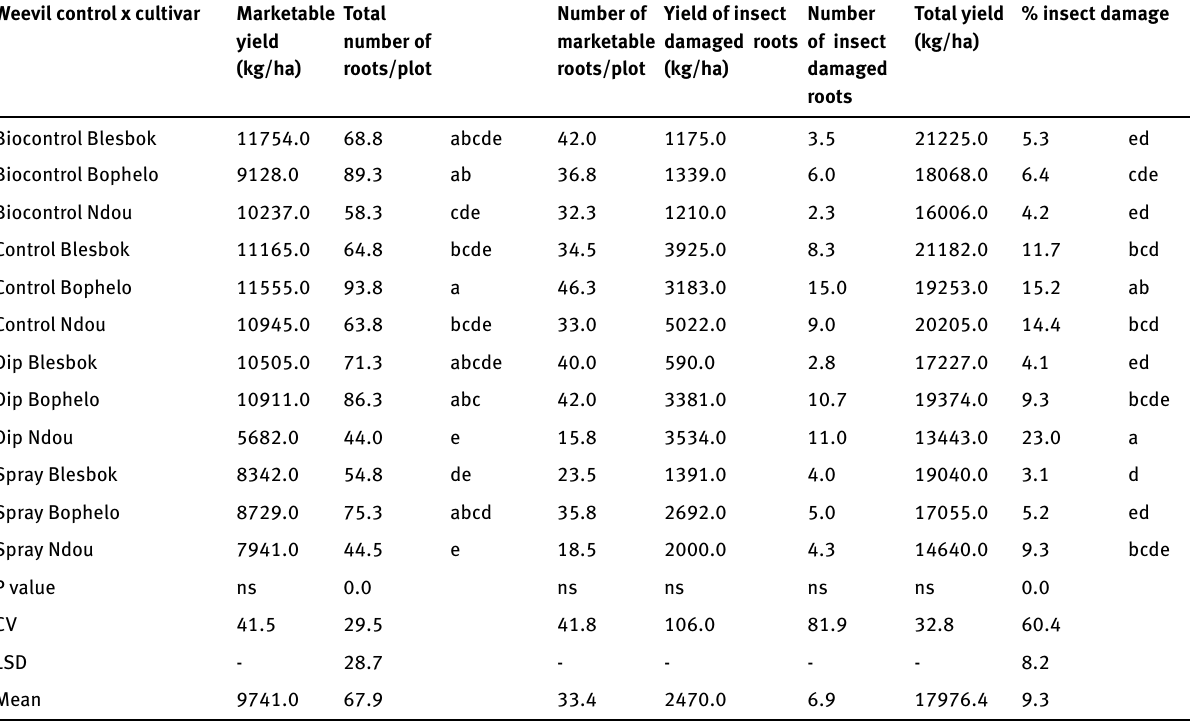
Table 3: Interaction of sweet potato cultivar and weevil management strategy (treatment) in a field trial at Roodeplaat, South Africa